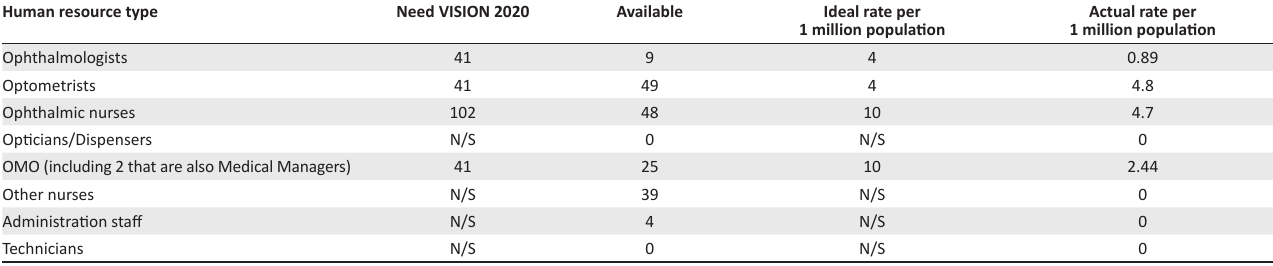
TABLE 1: Staffing gap analysis in line with VISION 2020 which specifies staffing quotas in relation to population size. Human resource type